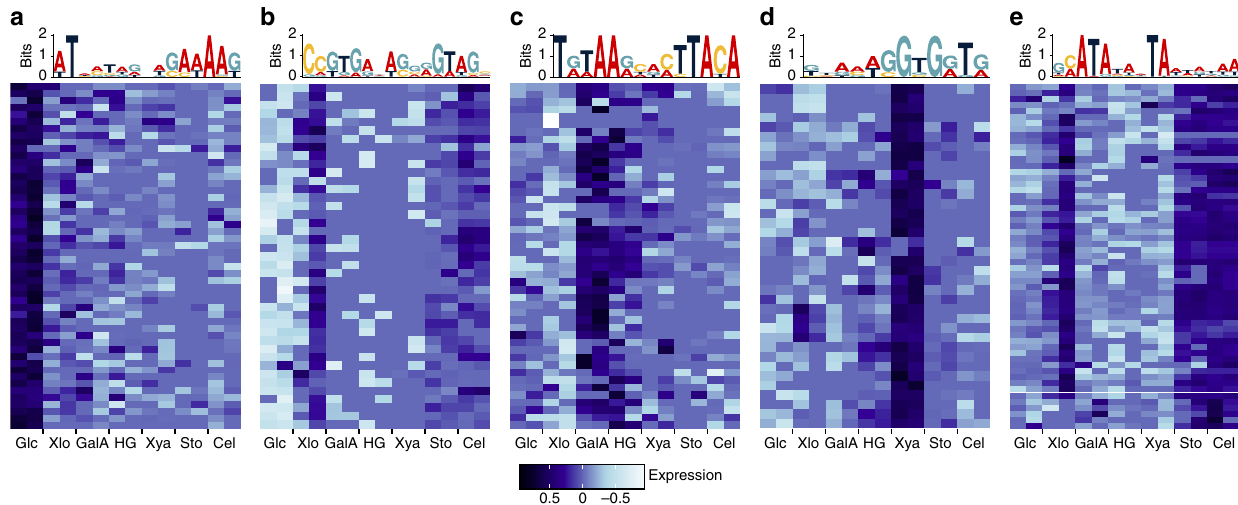
Figure 4 | TSS in carbon source-specific clusters share DNA sequence motifs. TSS clusters differentially expressed on ( a , b ) glucose, ( c ) galacturonic acid and HG, ( d ) xylan and ( e ) stover and cellulose are shown along with their associated sequence motifs. Rows are expression of a TSS cluster member and columns are duplicate glucose (Glc), xylose (Xlo), galacturonic acid (GalA), homogalacturonan (HG), xylan (Xya), stover (Sto) and cellulose (Cel) cultures. Colours show TSS expression as log 2 -transformed read counts scaled to a median of zero for each TSS.